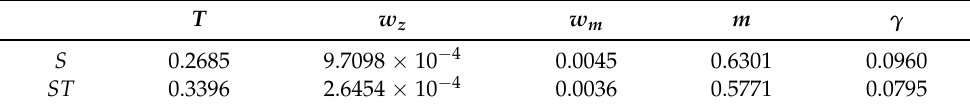
Figure 11. ( a ) First-order Sobol index pie charts and ( b ) total Sobol index pie charts representing the five parameters for travel time t . The five uncertain atmospheric environmental parameters are independently and uniformly distributed. The number of Sobol samples N is 2400. Table 4. First-order Sobol index S and total Sobol index ST of each atmospheric parameter for infrasound propagation travel time in a phase